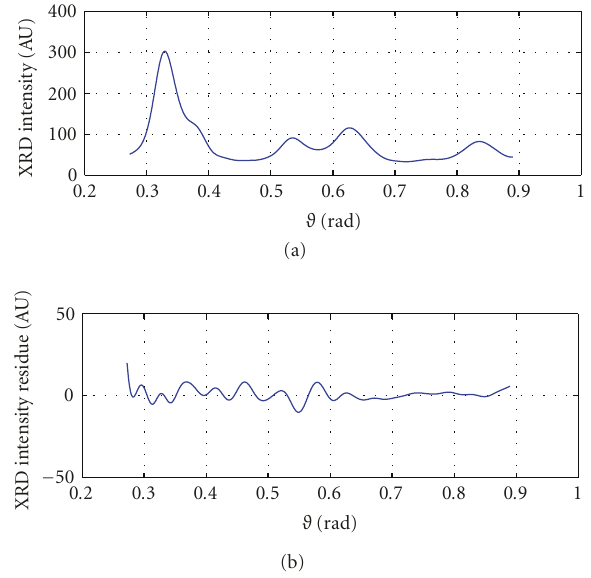
Figure 4: Three nm Au synthetic sample with NSR = 10%: (a) amplitude of eigenvalues λ k versus frequency f k , k = 1, ... , r ; (b) portion of the DFT amplitude spectrum of the noisy synthetic XRD intensity profile. Both plots refer to the XRD intensity profile shown at the top of Figure 3.